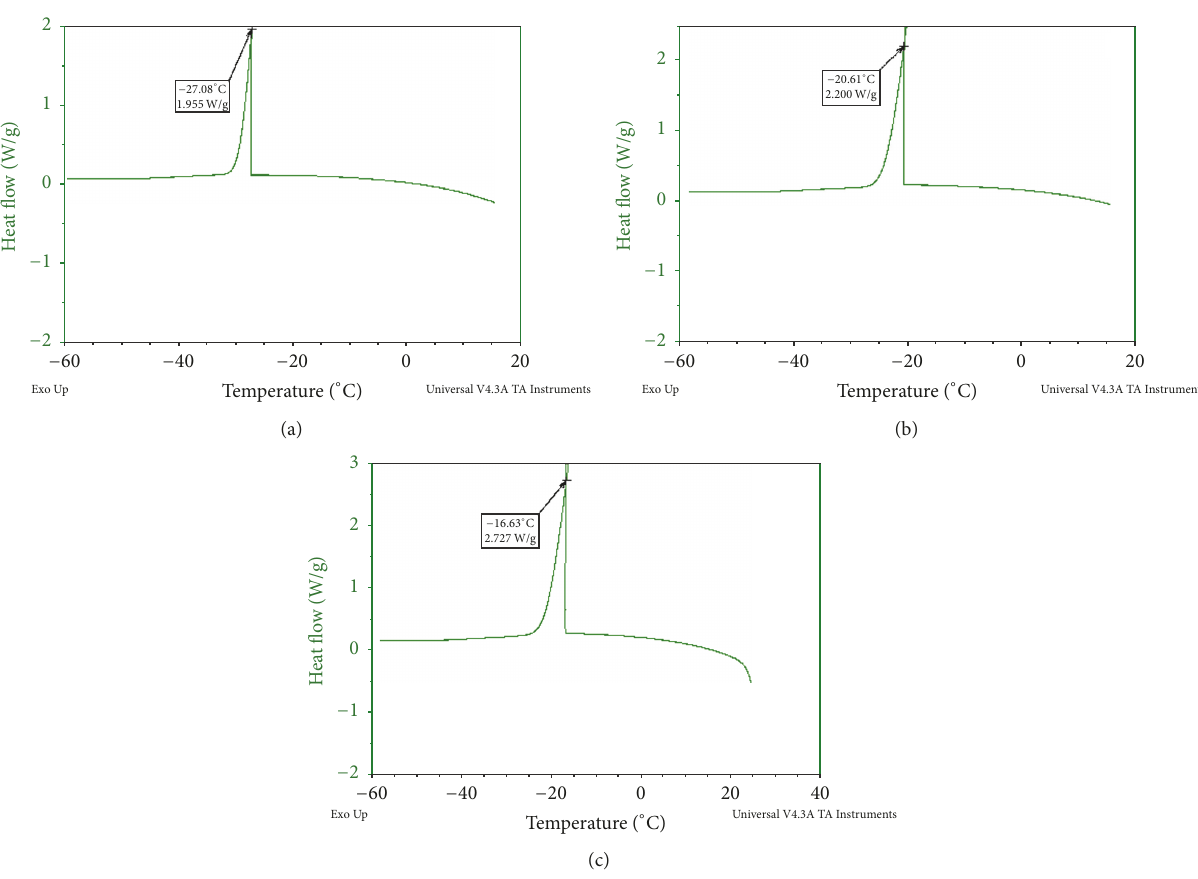
high Invertose content were the main reason for low eutectic point temperature of Feizixiao